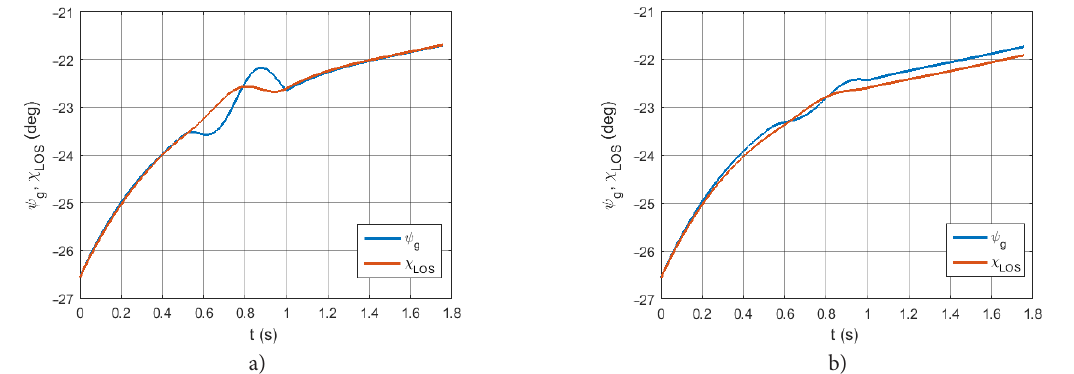
Figure 11. Yaw angle for LOS and gyroscope system axis, for: a) LQR, b) PD regulator